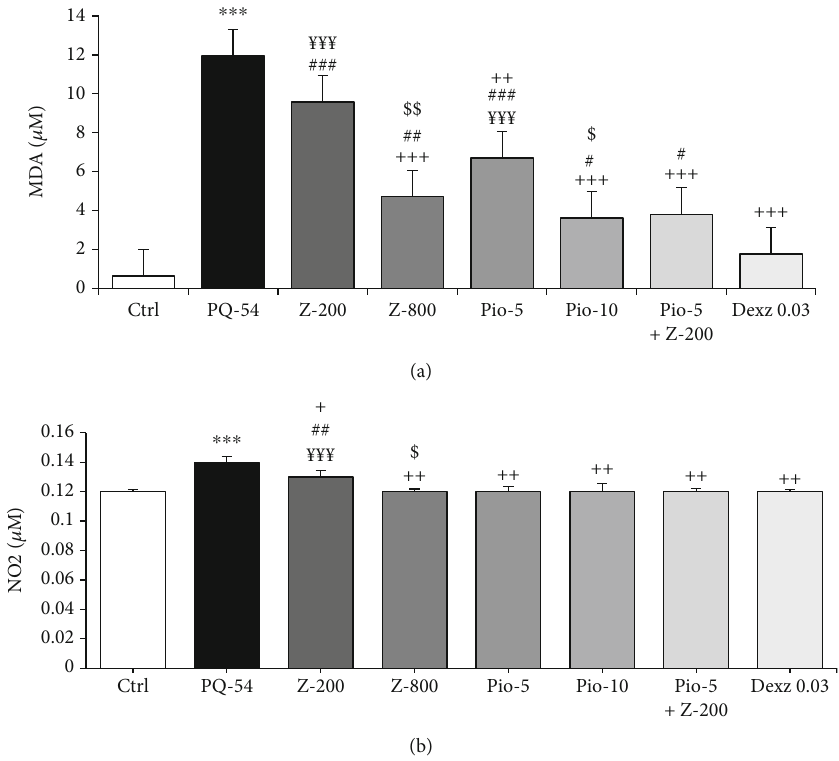
Figure 3: Serum levels of malondialdehyde (MDA) (a) and nitrite (NO ) (b) of control group (Ctrl), group exposed to paraquat aerosol at 2 doses of 54mg/m 3 (PQ-54), and groups exposed to PQ-54mg/m 3 and treated with 5 and 10 mg/kg/day pioglitazone, 200 and 800mg/kg/day Zataria multi fl ora , 0.03mg/kg/day dexamethasone, and 5mg/kg/day pioglitazone + 200 mg/kg/day Zataria multi fl ora (Pio- 5, Pio-10, Z-200, Z-800, Dexa 0.03, and Pio ‐ 5 + Z ‐ 200 , respectively). The results are expressed as the mean ± SEM ( n = 6 in each group). ∗∗∗